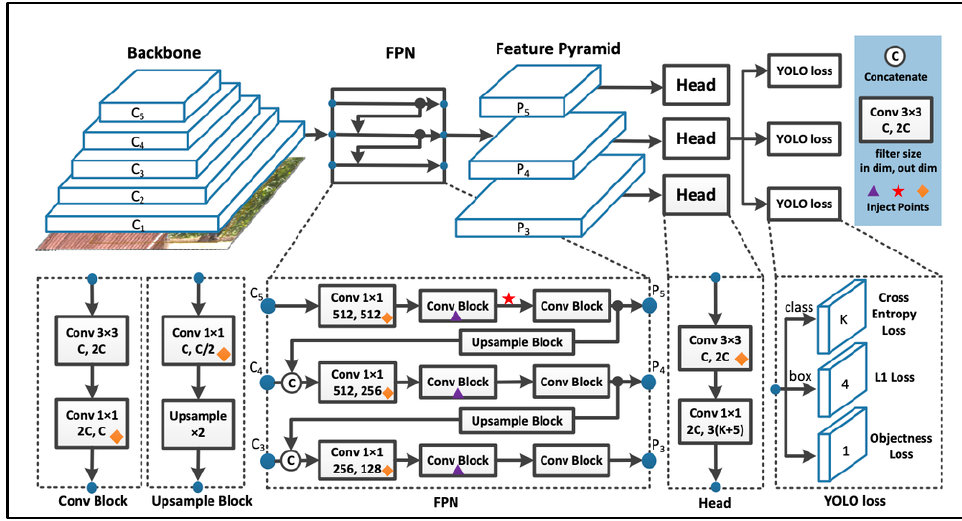
Figure 5. YOLOv7 Network